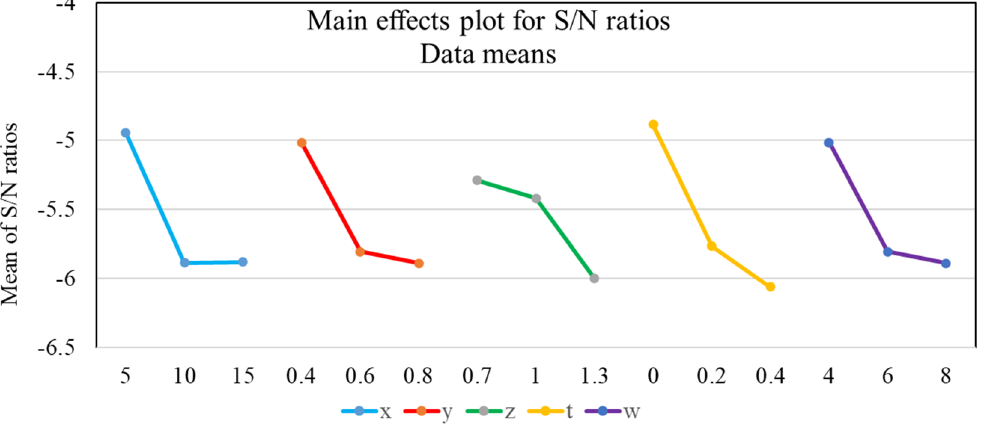
Figure 3. The results of the S/N analysis.